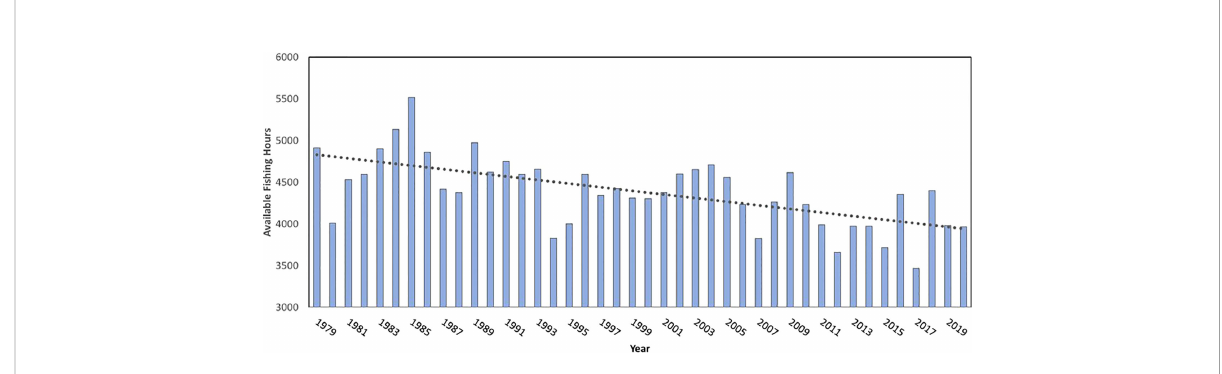
FIGURE 2 Total available fi shing hours by year for the Nosy Barren area between years 1979-2020. The trendline represents the linear regression (y = -21.71 + 47787) showing an overall signi fi cant decrease in available fi shing hours over time.